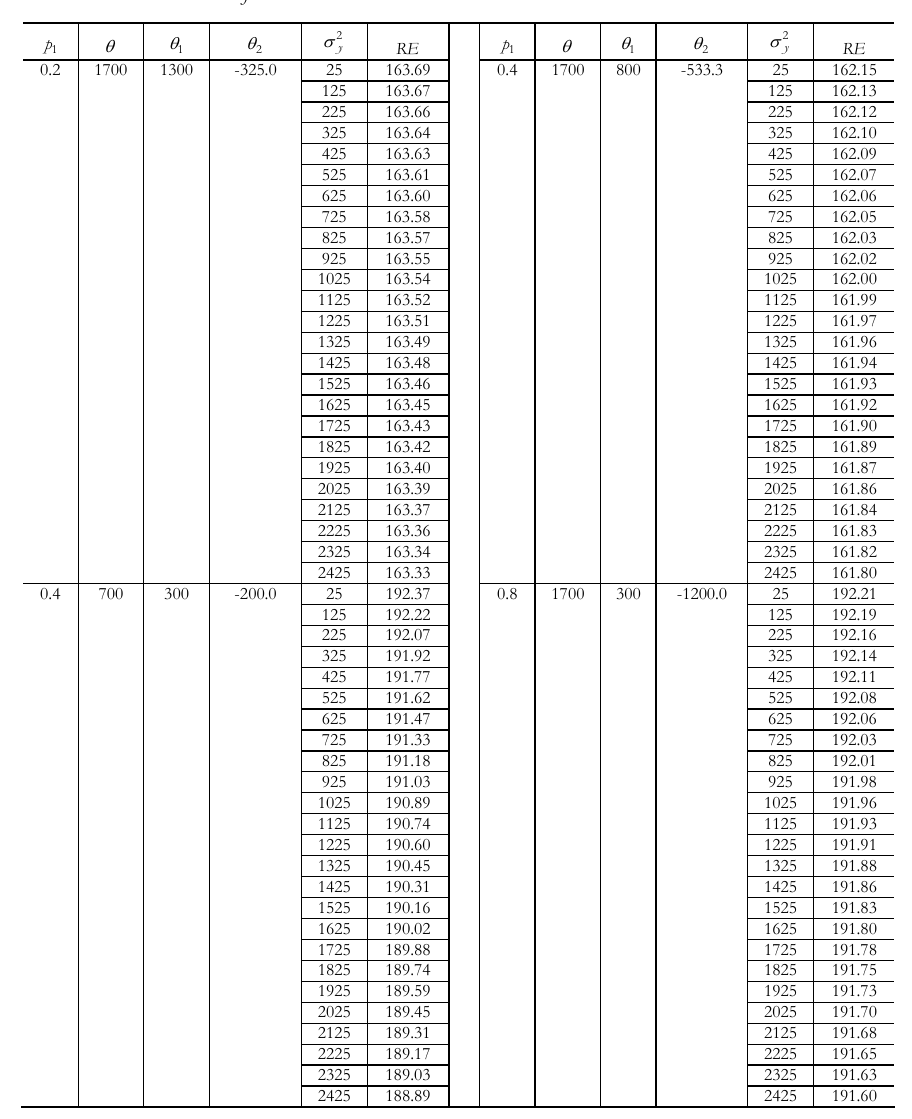
RE of the POONAM estimator over the GS estimator with 2 k